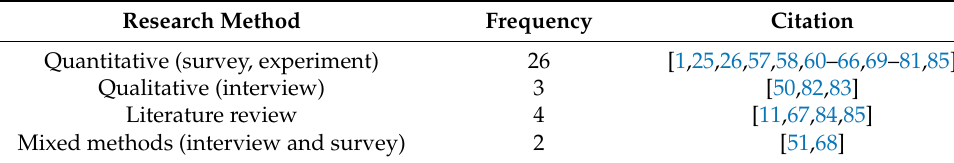
Table 4. Research methods of the selected studies.